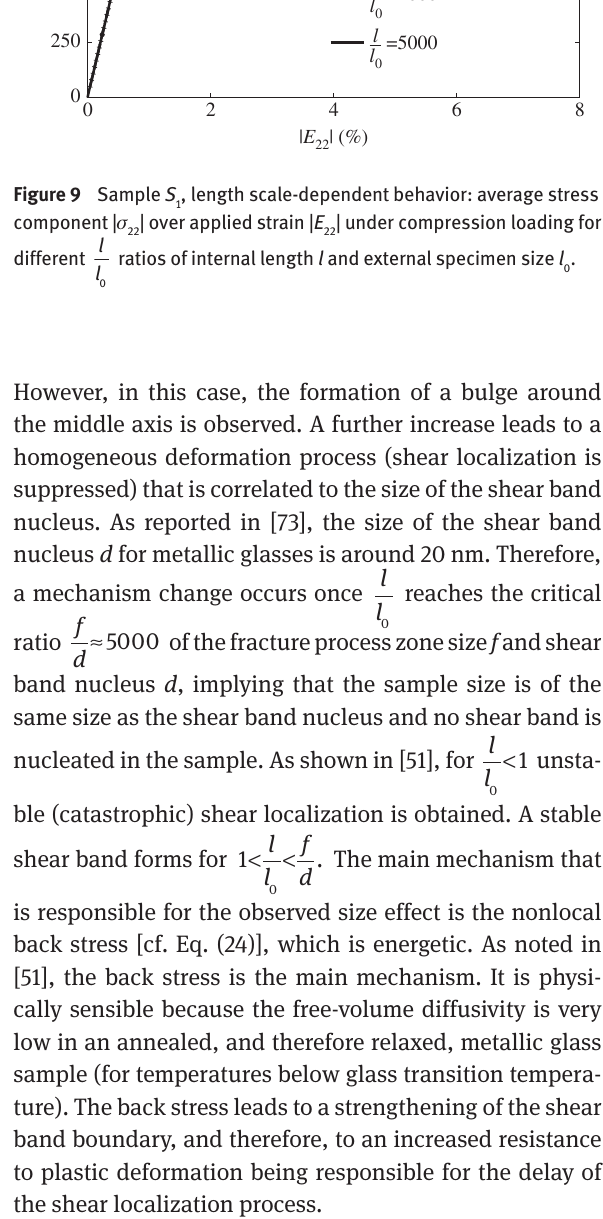
| under compression loading for 22